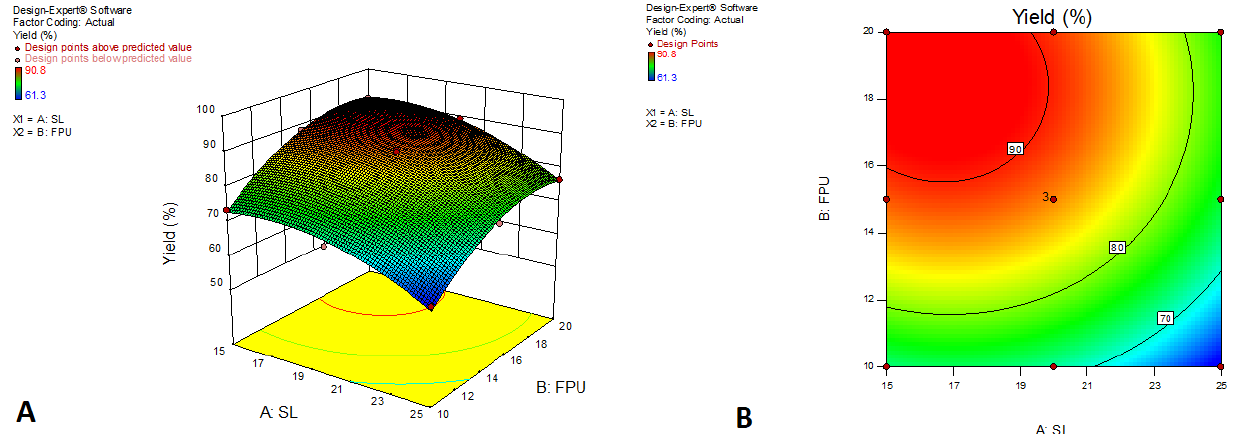
Figure 1. 3D surface plots of RSM analysis representing the relationship between two independent variables on the hydrolysis yield ( A ); corresponding contour plot showing the relationship between various levels of the two factors ( B ).